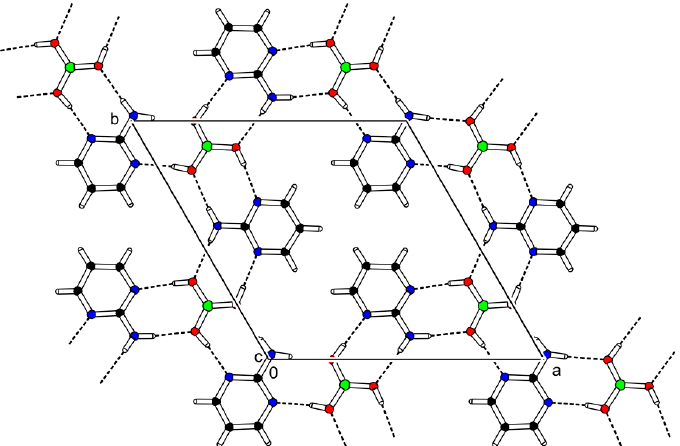
Figure 2. ORTEP plot of the asymmetric unit of (2-AMP) 3 (H 3 BO 3 ) 2 with atom numbering. The displacement parameters are shown at the 50% probability level.